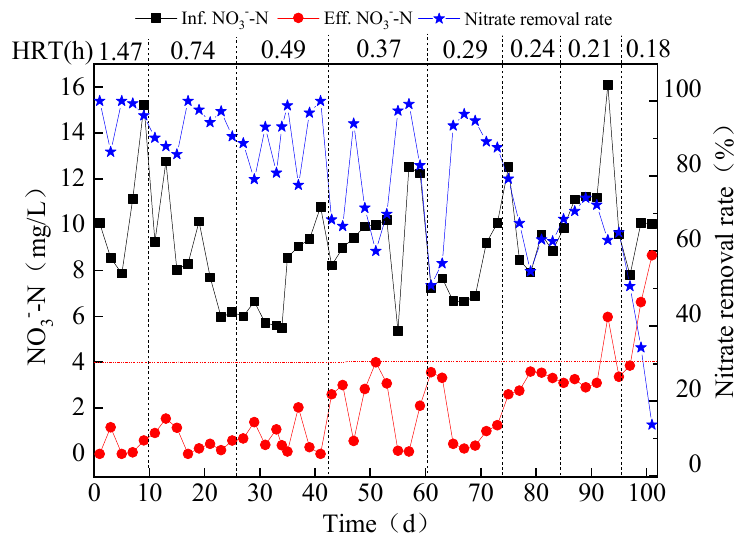
Figure 6. Nitrate removal performance under different HRT.